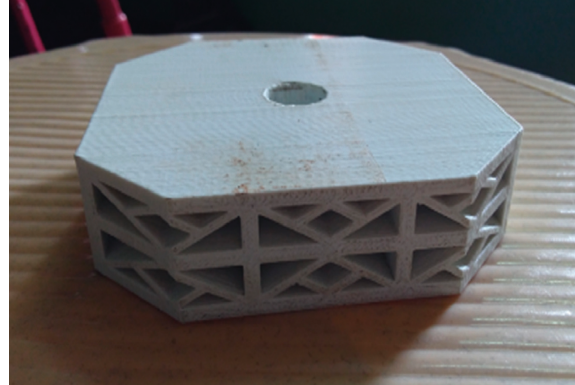
Figure 2: Proposed ABS compliant